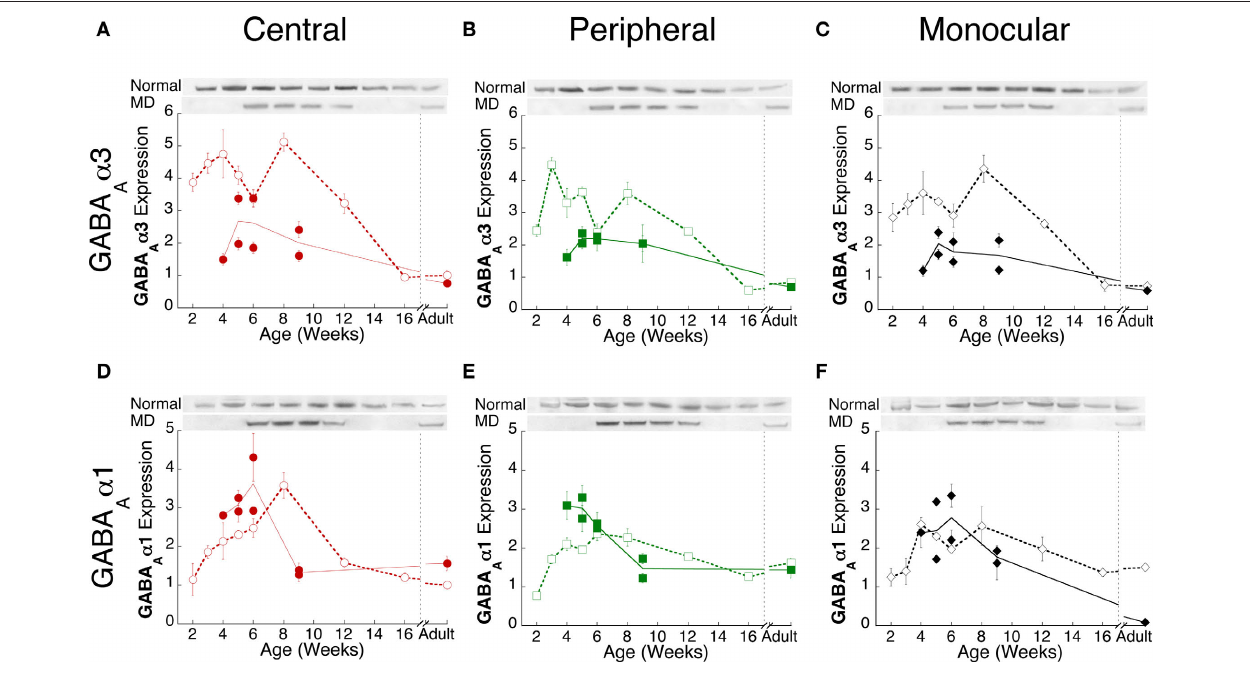
squares) and monocular (black diamonds) visual field representations during FiGure 5 | experience-dependent changes in GABA receptor subunit A postnatal development. For each subunit, the plots were normalized relative to expression. Comparison of GABA α 3 ( A–C ) and GABA α 1 ( D–F ) subunit A A the average normal adult expression in the central visual field. Error bars indicate expression in normal (open symbols, dashed lines) and monocularly deprived the s.e.m.. Representative Western blot bands are shown above each plot. (filled symbols, solid lines) kittens from the central (red circles), peripheral (green